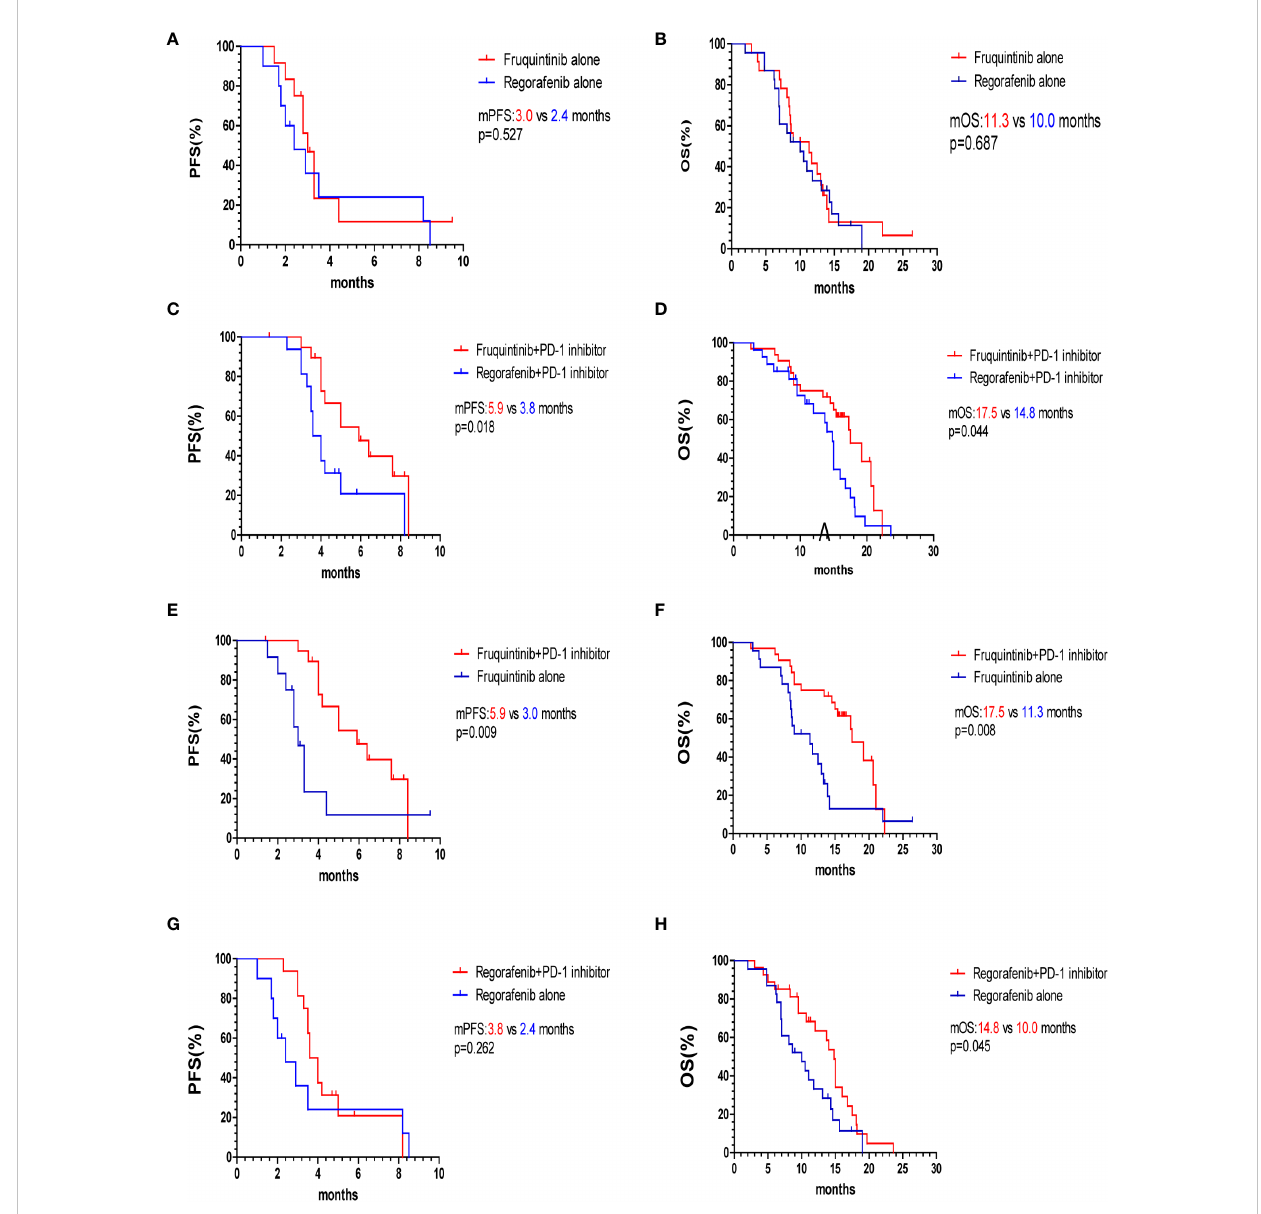
FIGURE 3 Kaplan – Meier survival curves of PFS and OS of two subgroups. (A, B) PFS and OS of fruquintinib and regorafenib monotherapy. (C, D) PFS and OS of FP and RP. (E, F) PFS and OS of fruquintinib with or without PD-1 inhibitors. (G, H) PFS and OS of regorafenib with or without PD-1 inhibitors. mPFS, median progression-free survival; mOS, overall survival; PD-1, programmed death